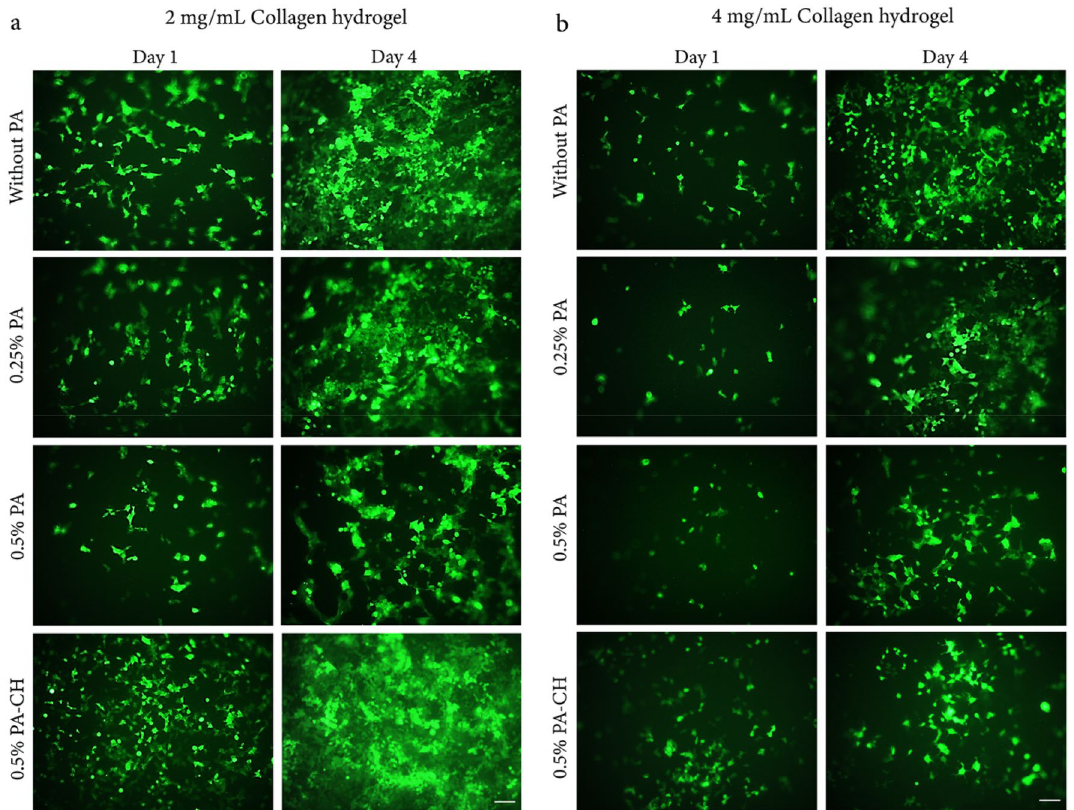
Figure 4. HEK293-T-GFP morphology, adhesion, and proliferation within collagen hydrogels. The HEK293- T-GFP adhered to ( a ) 2 mg/mL and ( b ) 4 mg/mL collagen hydrogel concentrations and all cross-linked collagen hydrogels (using 0.25% PA, 0.5% PA and 0.5% PA-CH). Over time, more GFP-positive cells were observed, indicating that the proliferated cells were GFP positive, as well. Cell proliferation was more prominent in hydrogels fabricated using 2 mg/mL